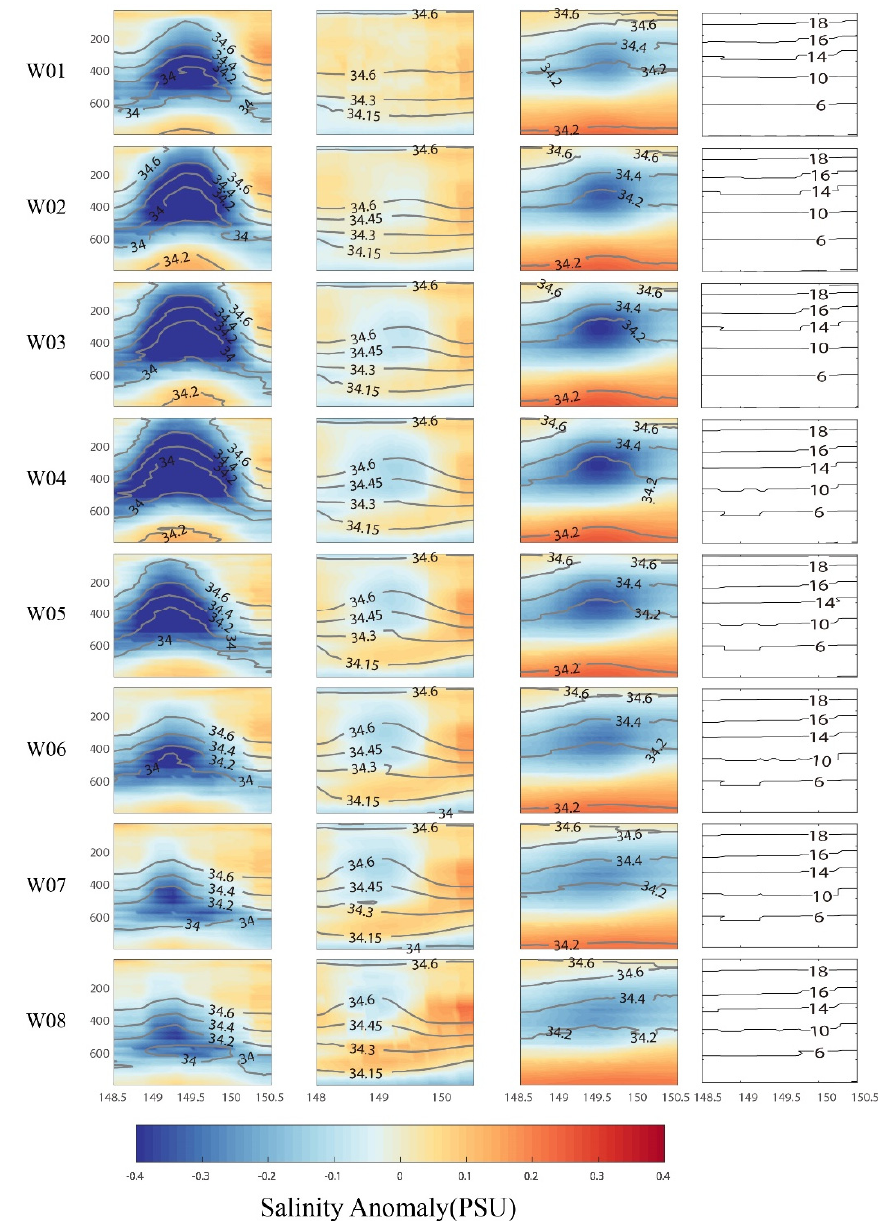
Figure 5. Sectional temperature distributions along the eight in situ sections. The horizontal axis is longitude and vertical axis is depth. The first column shows the temperature anomalies measured by MVPs, the second column shows ARMOR temperature anomalies, the third column shows the composite temperature anomalies, the fourth column shows the CARS09 (climatology). The gray lines represent the isotherms, and the color shading illustrates the temperature anomalies.